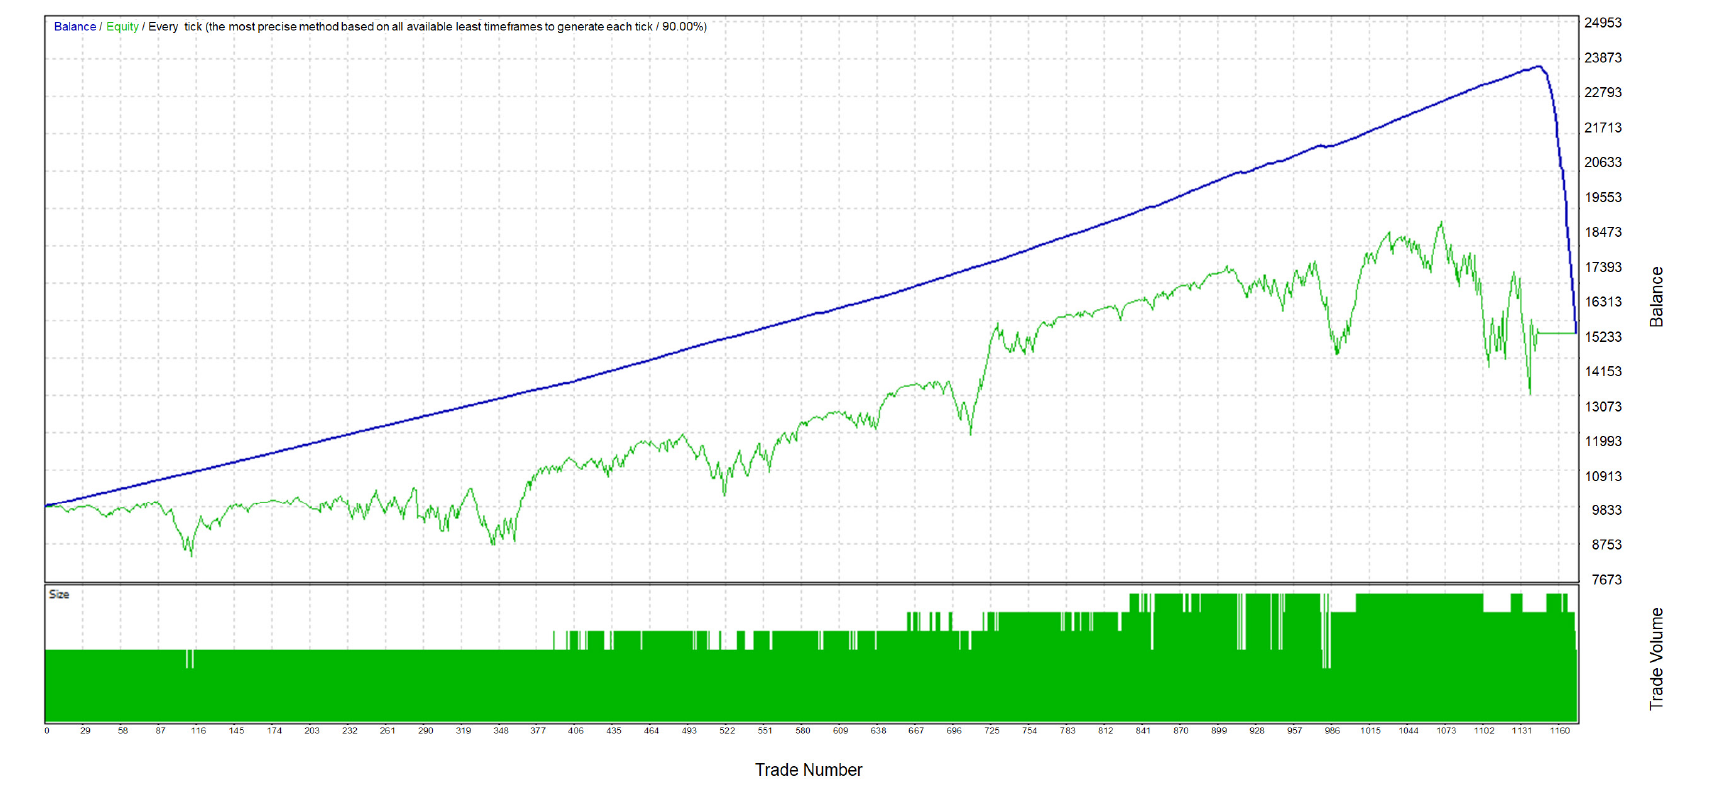
Blue Line = Balance, Green Line = Equity = Balance + Open